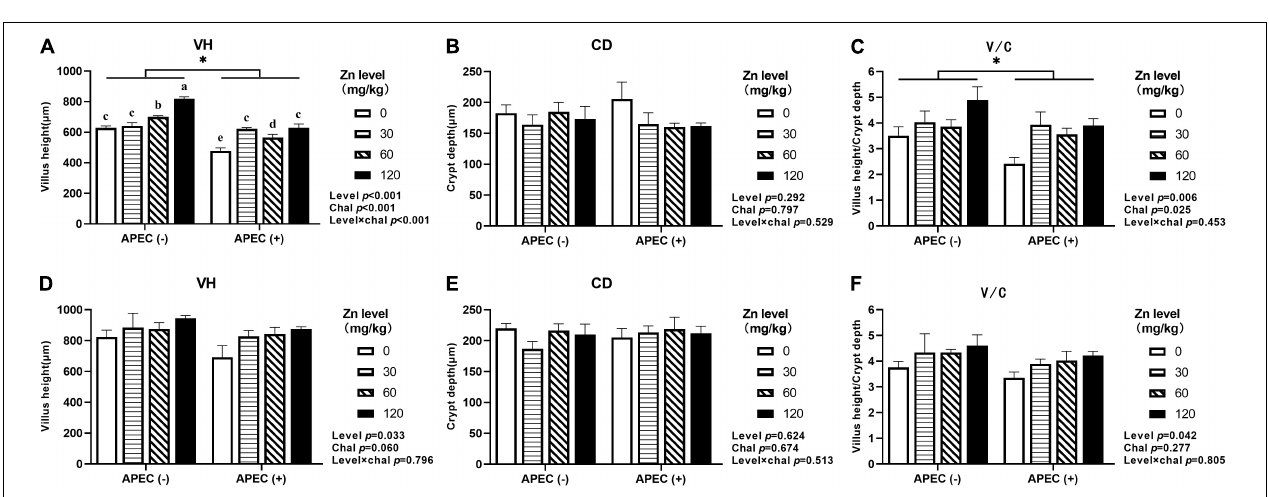
FIGURE 2 | Effect of dietary Zn–Met levels on serum levels of IgA (A) , IgG (B) , IgM (C) and complement C3 (D) and C4 (E) meat duck challenged with APEC O78 (8 DPI). Bars with different letters are statistically significant ( P < 0.05). Results are expressed as mean ± SEM ( n = 6).